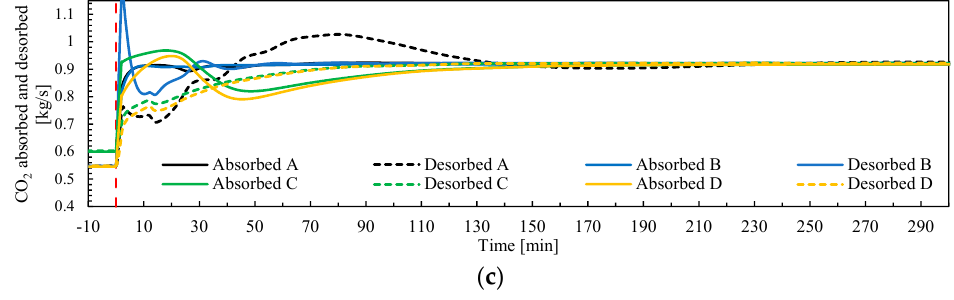
Figure 13. Outputs from pilot plant model during simulations for load change ramp-up (Test 2) from 70 to 100% with a ramp rate of 10%/min increase in flue gas flow rate, for control structures A, B, C and D. ( a ) CO 2 capture ratio Cap , as controlled variable (CV); ( b ) CO 2 desorption ratio Des ; ( c ) CO 2 absorption and desorption rates (kg/s). The red vertical dotted line shows when the transient event starts at t 0 .